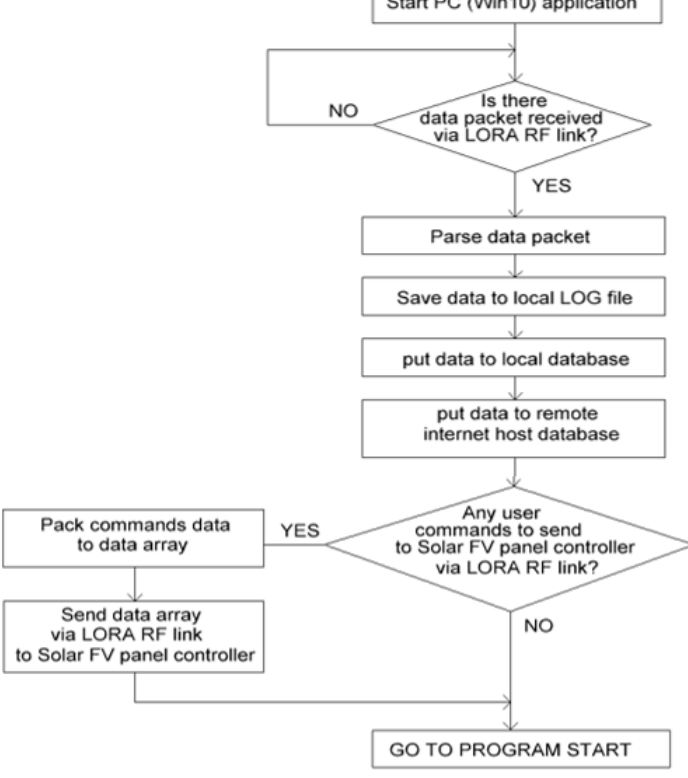
Figure 4. Scheme-algorithm of the server program code for receiving data from the solar plant and environmental parameters data controller.